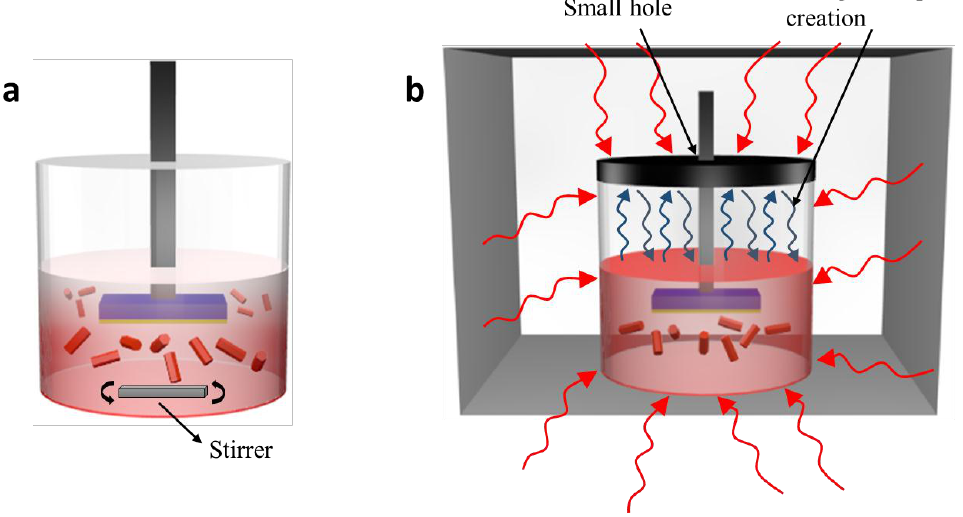
Figure 1. Heating profile for ( a ) aqueous chemical growth (ACG) and ( b ) microwave-assisted growth (MAG) methods. (MAG)